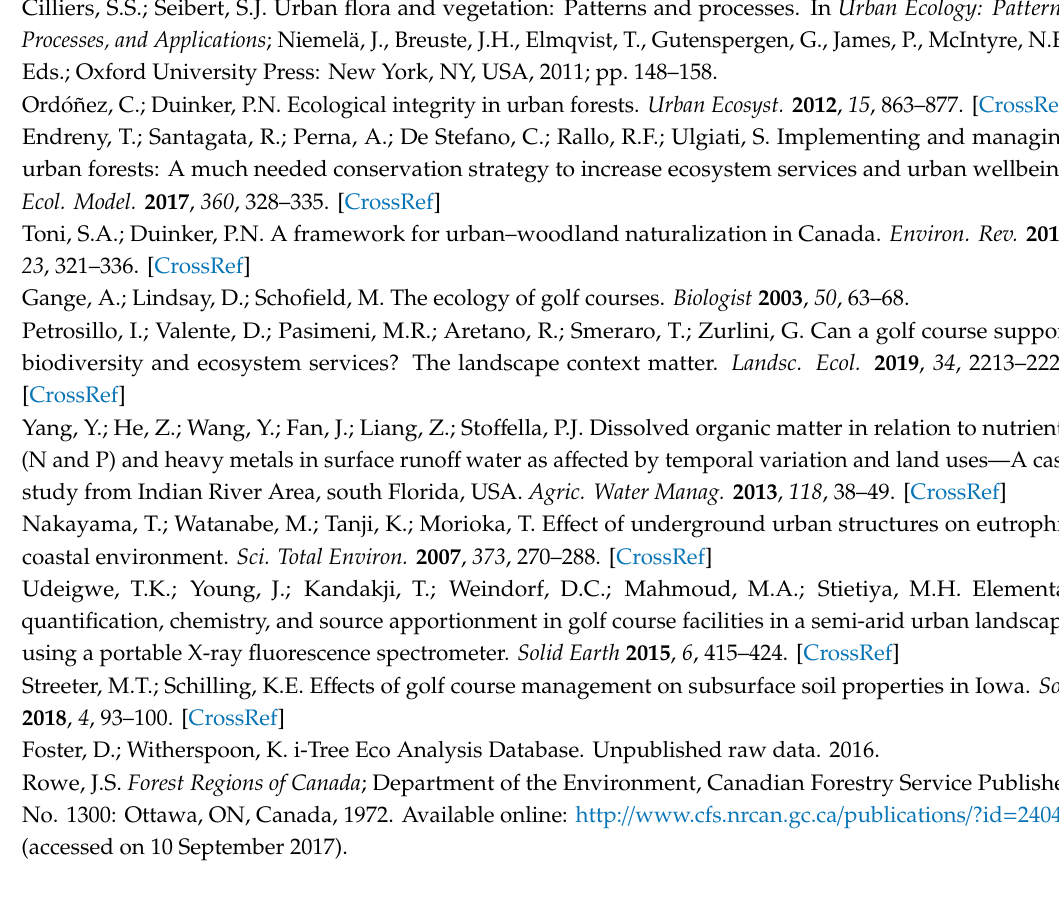
Figure A3. Total tree species distribution in Halifax ingrowth areas, 2016 (adapted from source data: [11]).